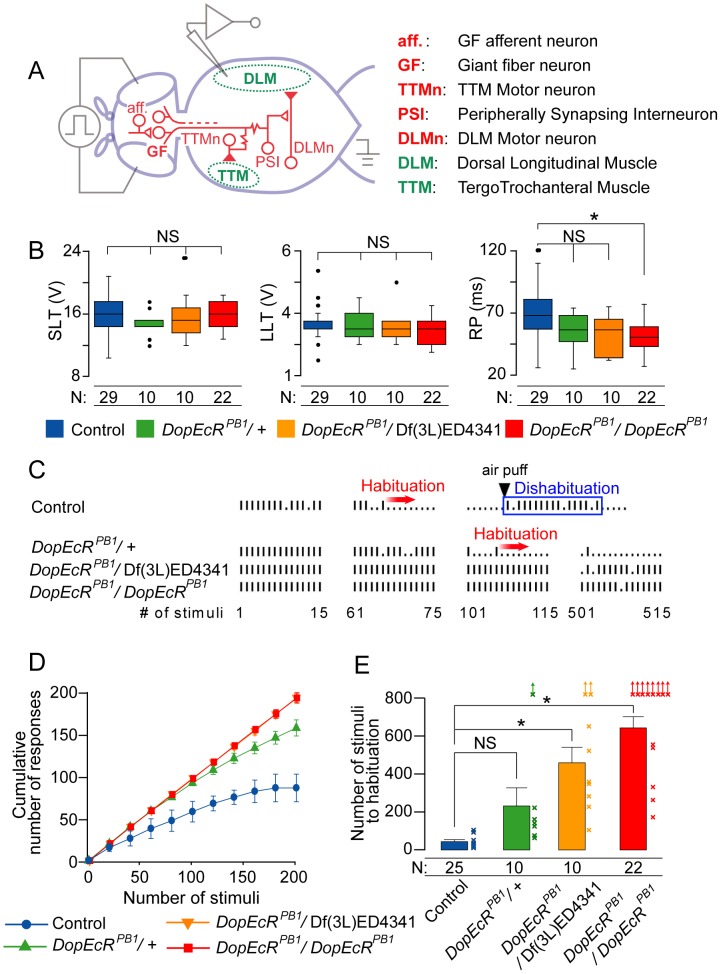

DopEcR loss-of-function mutants show slow habituation of the giant-fiber escape circuit.(A) Schematic representation of the giant-fiber (GF) pathway. GF afferent neurons (aff.). Tergotrochanteral muscle (TTM), TTM motor neuron (TTMn), dorsal longitudinal muscle (DLM), peripherally synapsing interneuron (PSI), and DLM motor neuron (DLMn). (B) The long-latency threshold (LLT), short-latency threshold (SLT) and refractory period (RP) for DopEcR mutants and wild-type flies. The data are presented as box plots. (C) Representative traces of muscle responses to 5-Hz brain stimulation. Vertical bars and dots denote successful and failed responses, respectively. An arrowhead represents the time at which a gentle air puff was applied to trigger dishabituation, which confirms that the failure to respond is due to habituation. (D) Cumulative muscle responses to 5-Hz brain stimulations. (E) The average numbers of 5-Hz stimuli delivered before the fly experiences five consecutive failures (criteria for habituation). Crosses with arrows represent flies that did not show habituation within the observation period (2 minutes). Error bars (s.e.m). Data were analyzed by Krustal-Wallis One-Way ANOVA, followed by Dunn's pairwise test for multiple comparisons. NS, no significant difference. *, P<0.05.